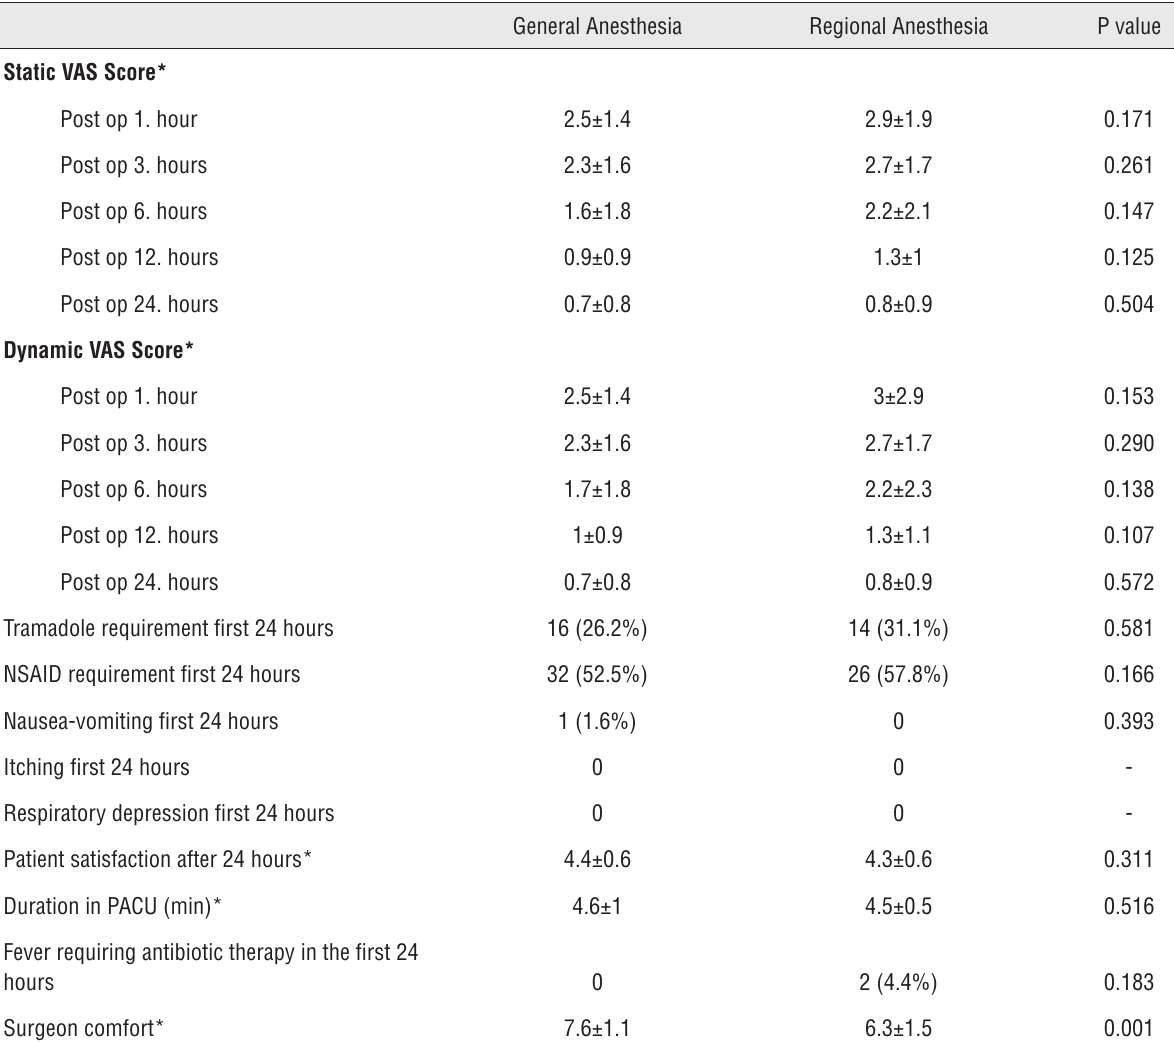
Table 3 - Comparison of postoperative parameters and